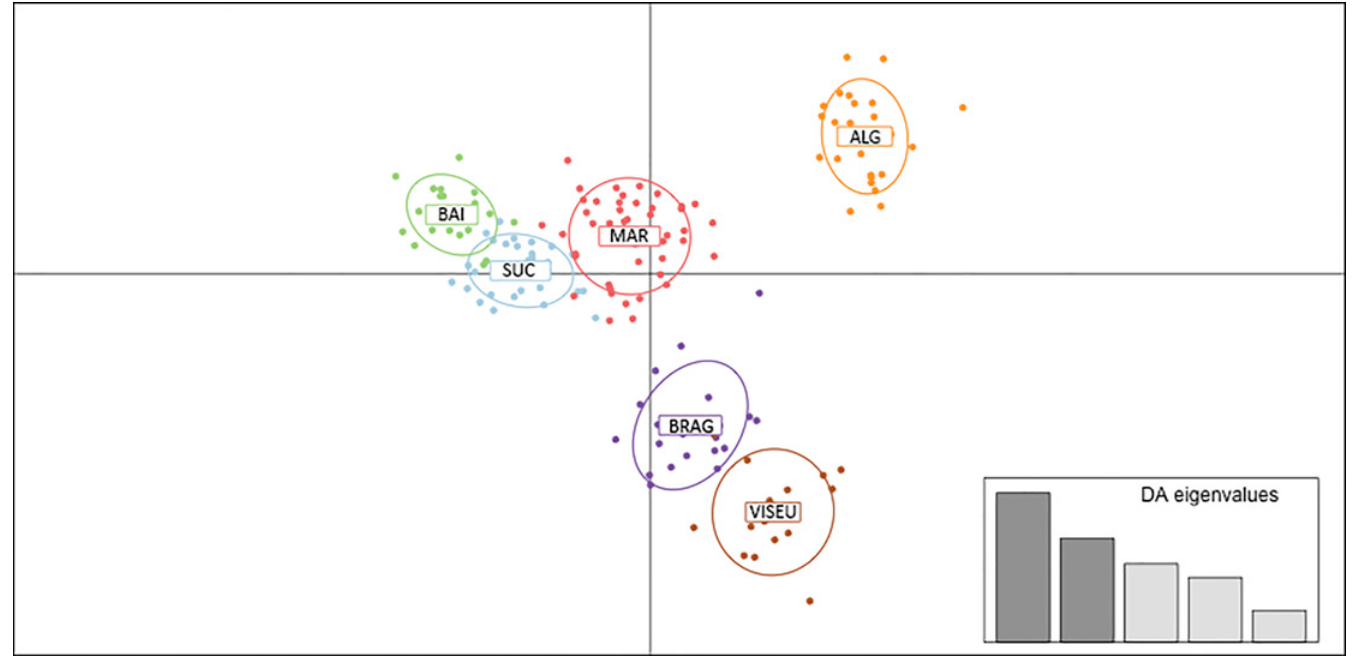
Fig 2. Plot of the first two axes obtained in the DAPC. Color circles represent each individual (the colors represent the same groups presented in Fig 1). The bar graph inset presents the eigenvalues of the five principal components (PCs), in terms of their relative magnitude. BAI, Bailique Island; SUC, Sucuriju; MAR, Marajó Island; ALG, Algodoal Island; BRAG, Bragança; and VISEU,